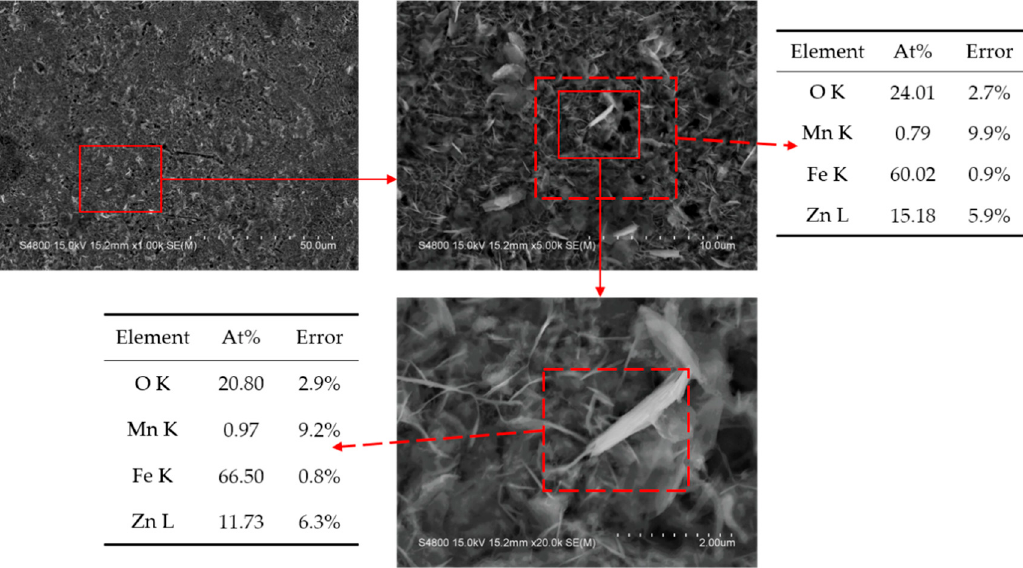
Figure 6. SEM images and the corresponding composition analysis of the passive film formed on A508-3 with the zinc treatment.